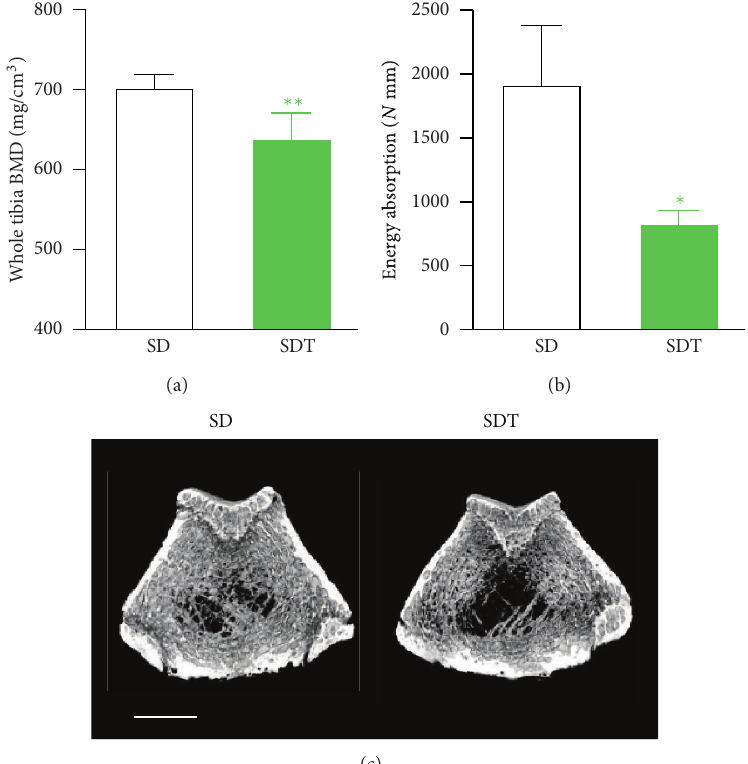
F 8: Bone properties of SDT rats. Bone mineral density (BMD) of the whole tibia (a) and mechanical property of the femur midsha (b) are clearly indicating diabetes-induced osteoporosis in SDT rats. White column: male SD rats, green column: male SDT rats (40 weeks of , (versus SD rats, unpaired t -test). e reconstructed bone microstructure age). Data represent means SD ( ). 3D images of femur from 40 weeks SDT rats show the obvious bone loss (c) (bar 2mm). Figures are modi�ed from ∗∗ ∗ 𝑃𝑃 𝑃 𝑃𝑃𝑃𝑃 𝑃𝑃 𝑃 𝑃𝑃𝑃𝑁 ± 𝑁𝑁 𝑁 𝑁 𝑁